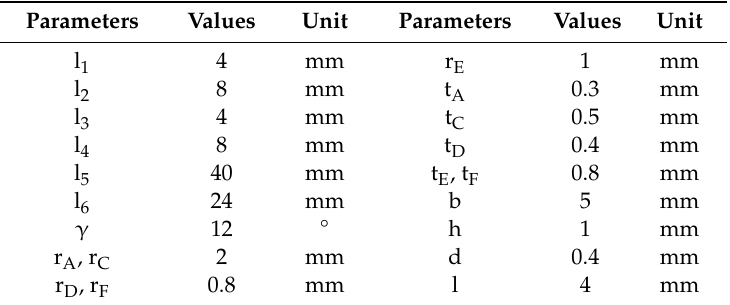
Table 1. Parameters of the